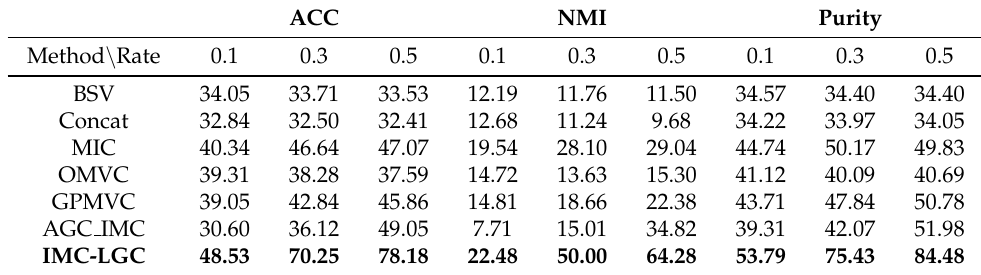
Table 1. Average values of ACC (%), NMI (%), and purity (%) of different methods on the BBCSport dataset with different observed rates of paired samples. Bold numbers denote the best results.